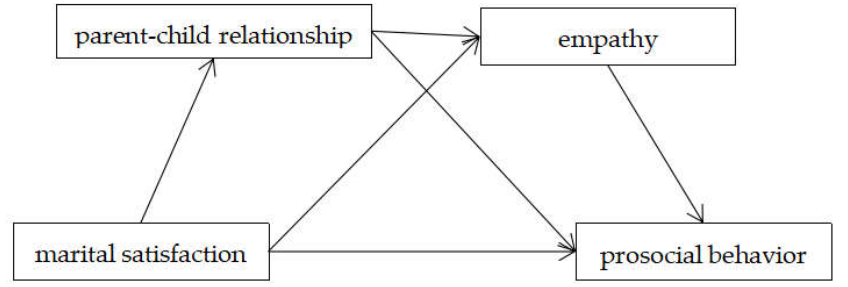
Figure 1. Conceptual model.